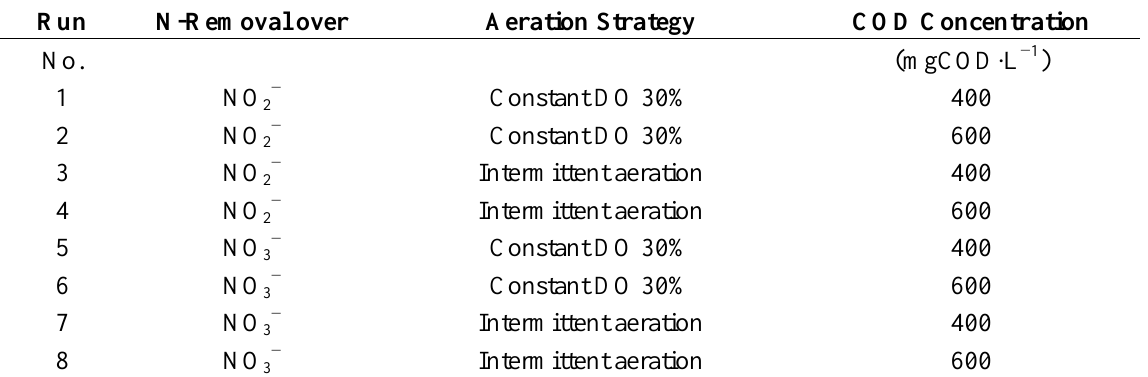
O concentrations and N 2